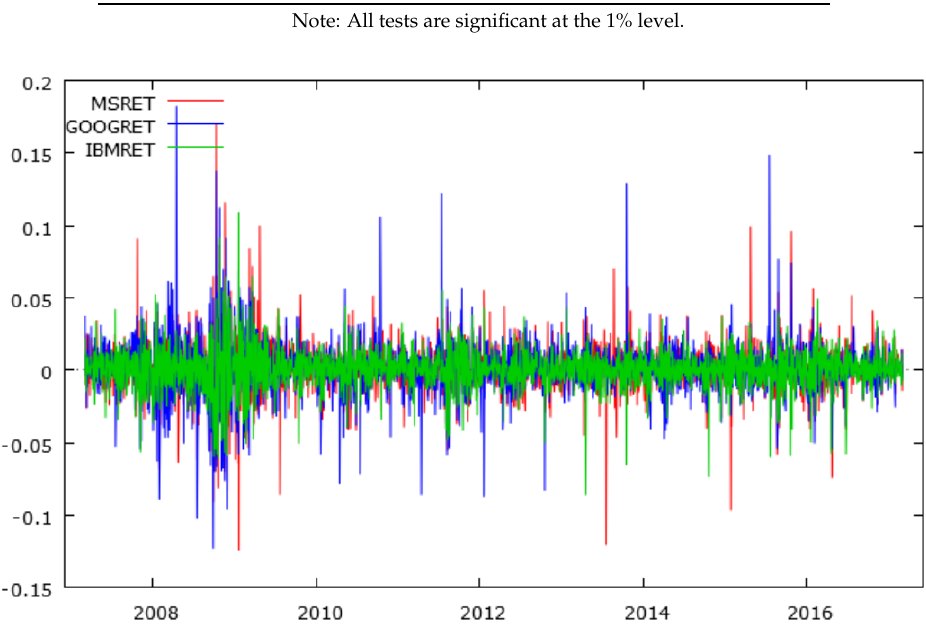
Figure 1. Plots of return